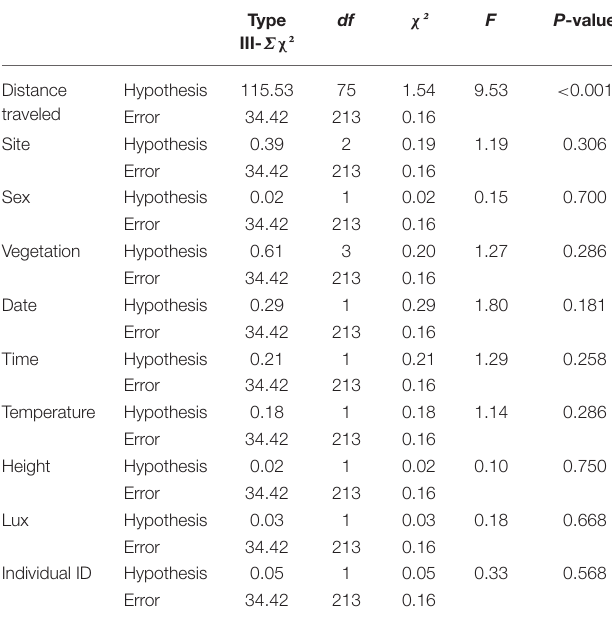
TABLE 2 | GLM to test the relationships between directionality and other factors collected during the tracking experiment to investigate the brumation behavior of Dryophytes suweonensis